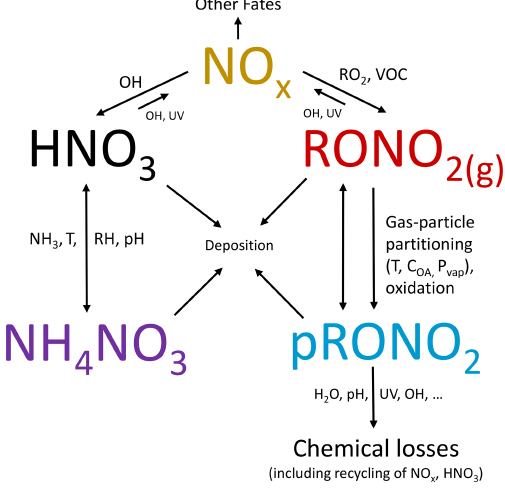
Figure 6. Schematic of key processes controlling particle-phase NH 4 NO 3 and pRONO 2